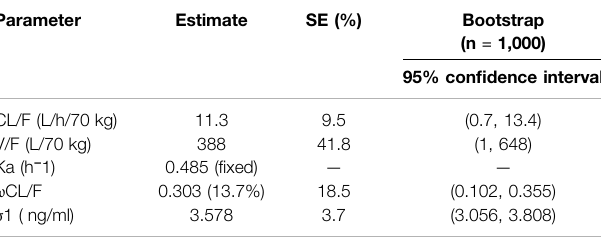
TABLE 2 | Parameter estimates of fi nal model and bootstrap